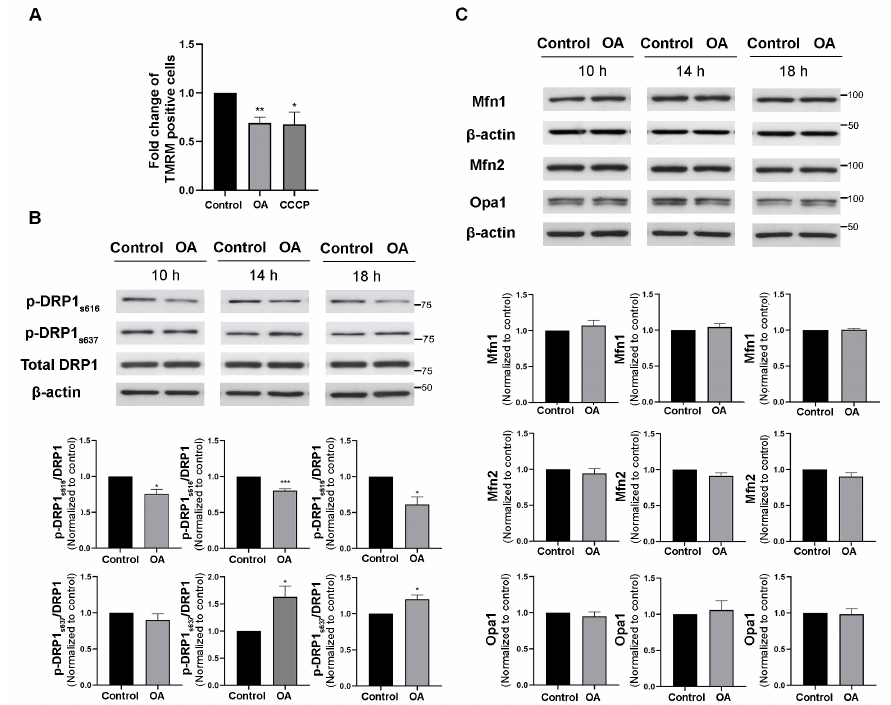
Figure 3. Effects of PP2A inhibition on mitochondrial membrane potential and dynamics. ( A ) Bar graph representing the fold change of TMRM-positive cells normalized with the control. Western blot analysis of ( B ) fission markers, including p-DRP s616 , p-DRP s637 , and DRP1, and ( C ) fusion markers, including mfn1, mfn2, and Opa-1, at 10 h, 14 h, and 18 h after okadaic acid treatment. The bar graphs show quantifications of the blots normalized with b-actin. Data represent means ± SEMs of three independent experiments. * p < 0.05, ** p < 0.01, *** p < 0.001 (Student’s t